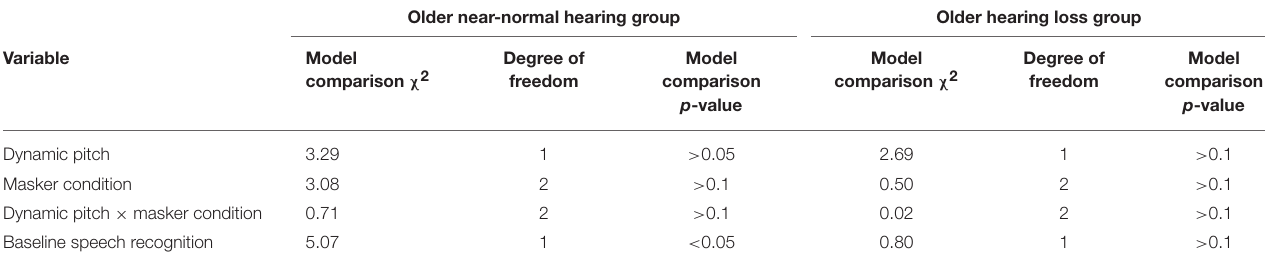
TABLE 3 | Model comparison χ 2 and p -values dynamic pitch benefit of the older near-normal hearing group ( n = 18) and the older group with hearing loss ( n =